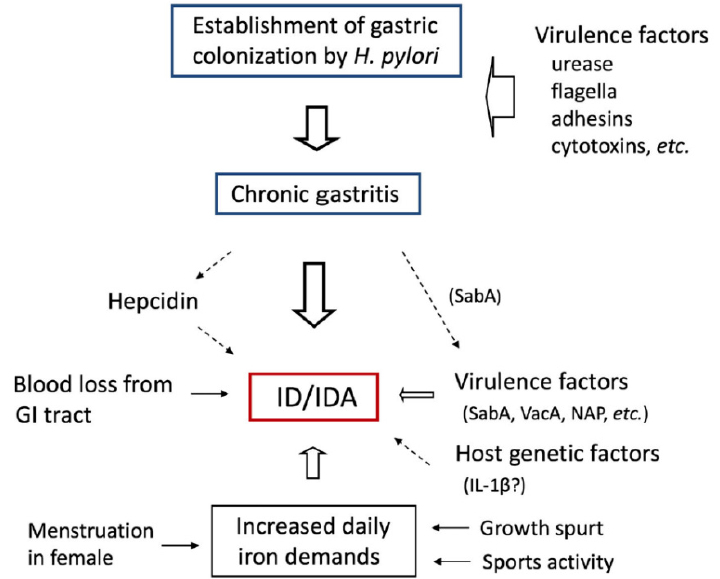
Figure 2. Possible pathogenesis of H. pylori -associated IDA in childhood and adolescence.